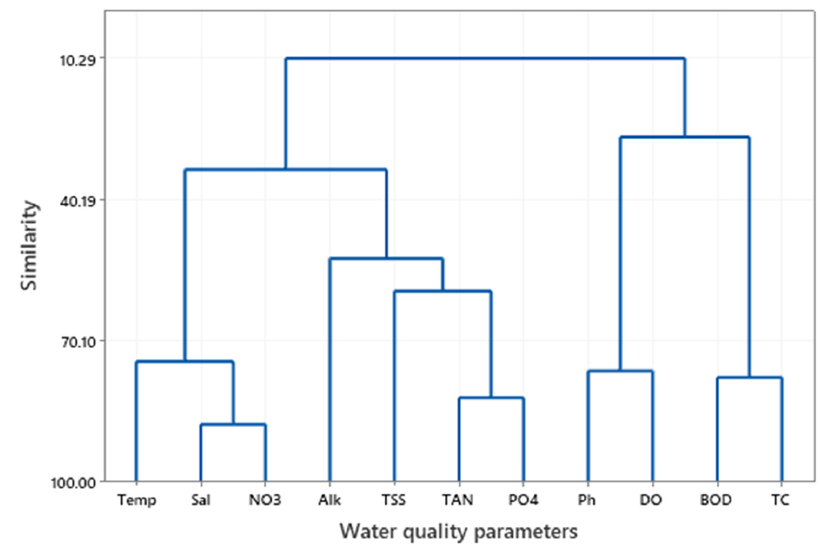
Figure 4. Clustering water quality parameters.